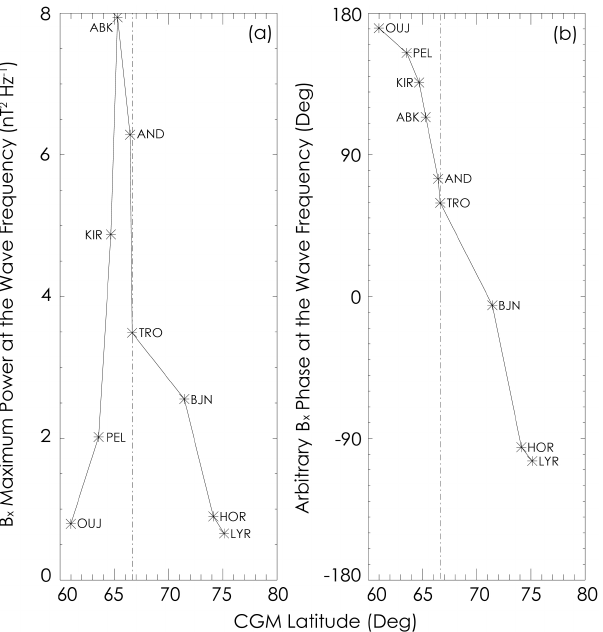
Fig. 4. IMAGE Magnetometer data for the ULF wave event on 16 April 1998. Panels (a) and (b) show the latitudinal Fourier power and phase profiles for the X component of the magnetic field, re- spectively. In both panels the overlaid dot-dash line shows the loca- tion of the DOPE instrument.